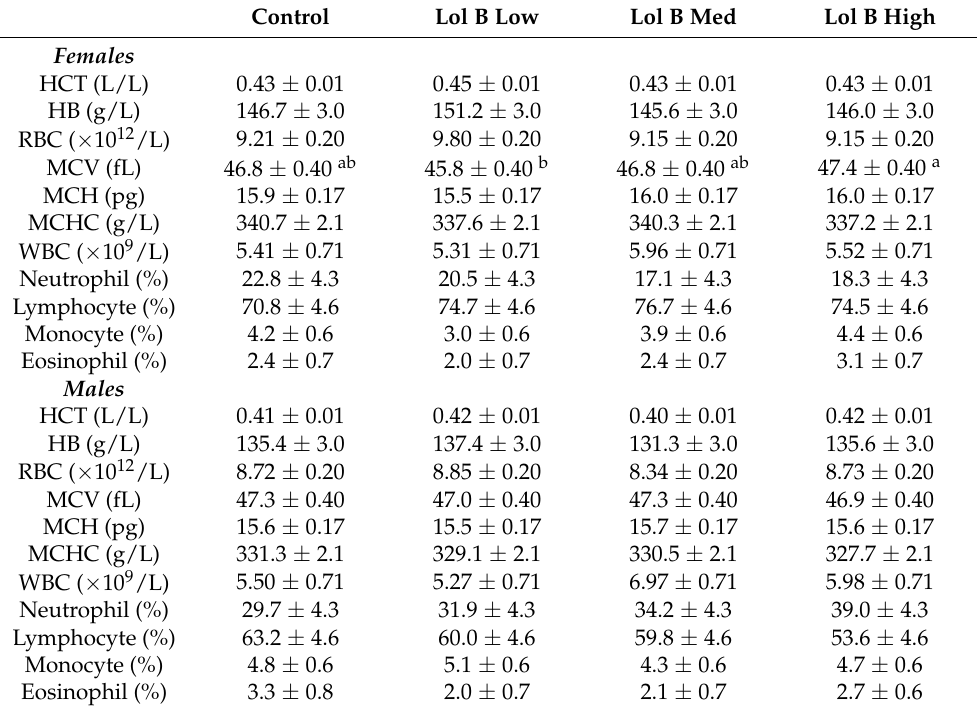
Table 6. Hematology data of mice fed control, lol B low, lol B med or lol B high diets (containing 0, 0.265, 0.53 or 1.06 ppm lolitrem B, respectively) for 90